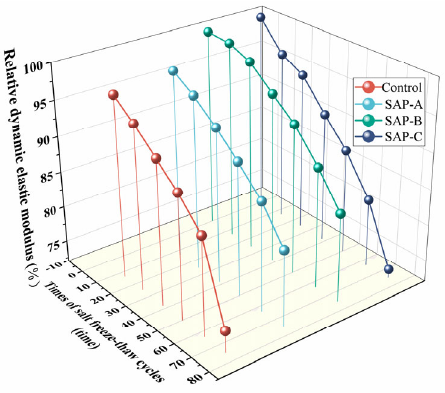
Figure 4. Relative dynamic elastic modulus of pavement concretes with different times of salt freeze–thaw cycles.